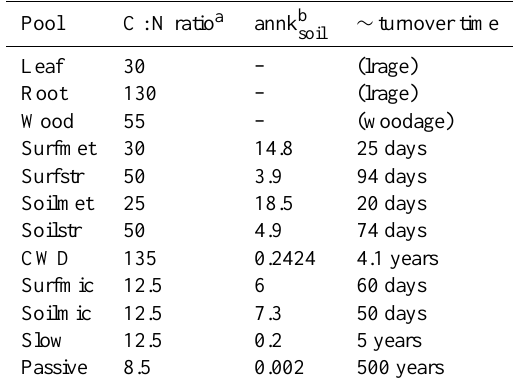
Table B1. Values of C pool parameters: C:N ratio of all 12 C pools (used only to calculate N pools); annk soil – inverse of turnover times of all 9 soil C pools (year − 1 )